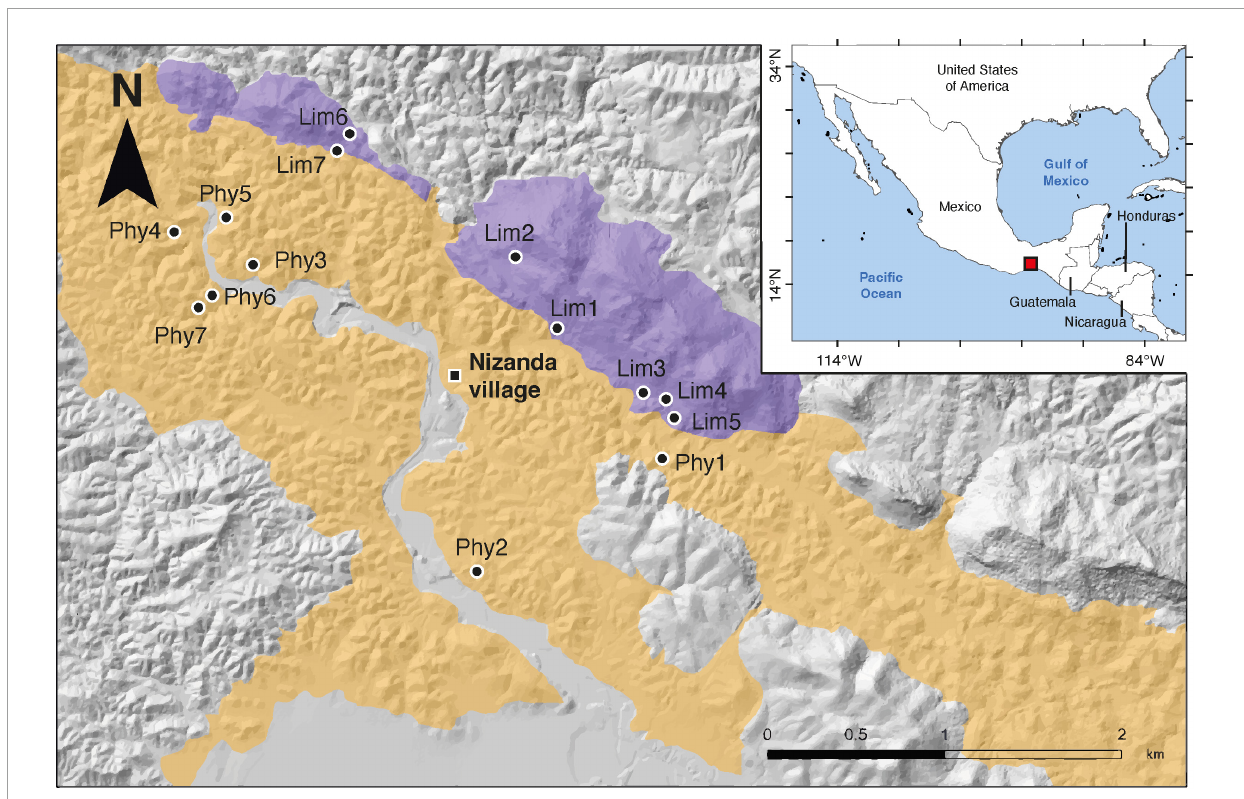
FIGURE1 Map of the study area in the tropical dry forest (TDF) region of Nizanda, Mexico. Locations of the permanent old-growth TDF plots on soils derived from limestone bedrock (purple shading) and siliciclastic phyllite bedrock (yellow shading) are shown. Gray shading represents other parental materials occurring in the area (see Pérez-Gutiérrez et al., 2009). Inset map shows the location of the Nizanda region within